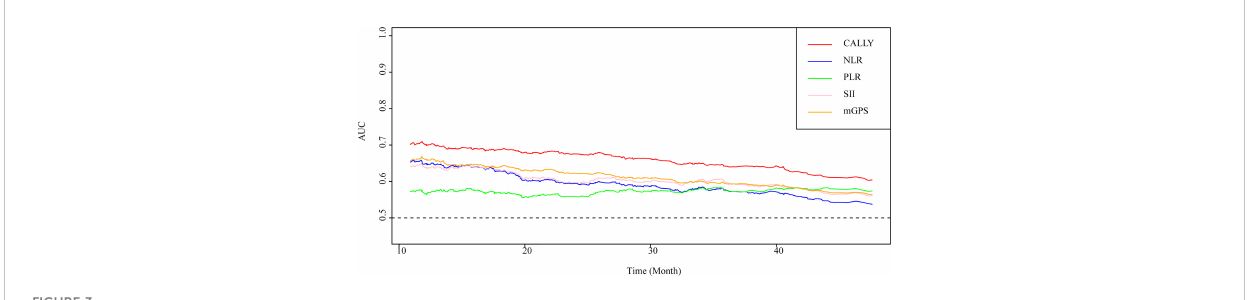
FIGURE 3 AUC of the CALLY index and classical CRC prognostic factors in patients with CRC. AUC, area under the ROC curve; ROC, receiver operating characteristic; CALLY, C-reactive protein-albumin-lymphocyte; CRC, colorectal cancer; mGPS, modi fi ed Glasgow prognostic score; NLR, neutrocyte